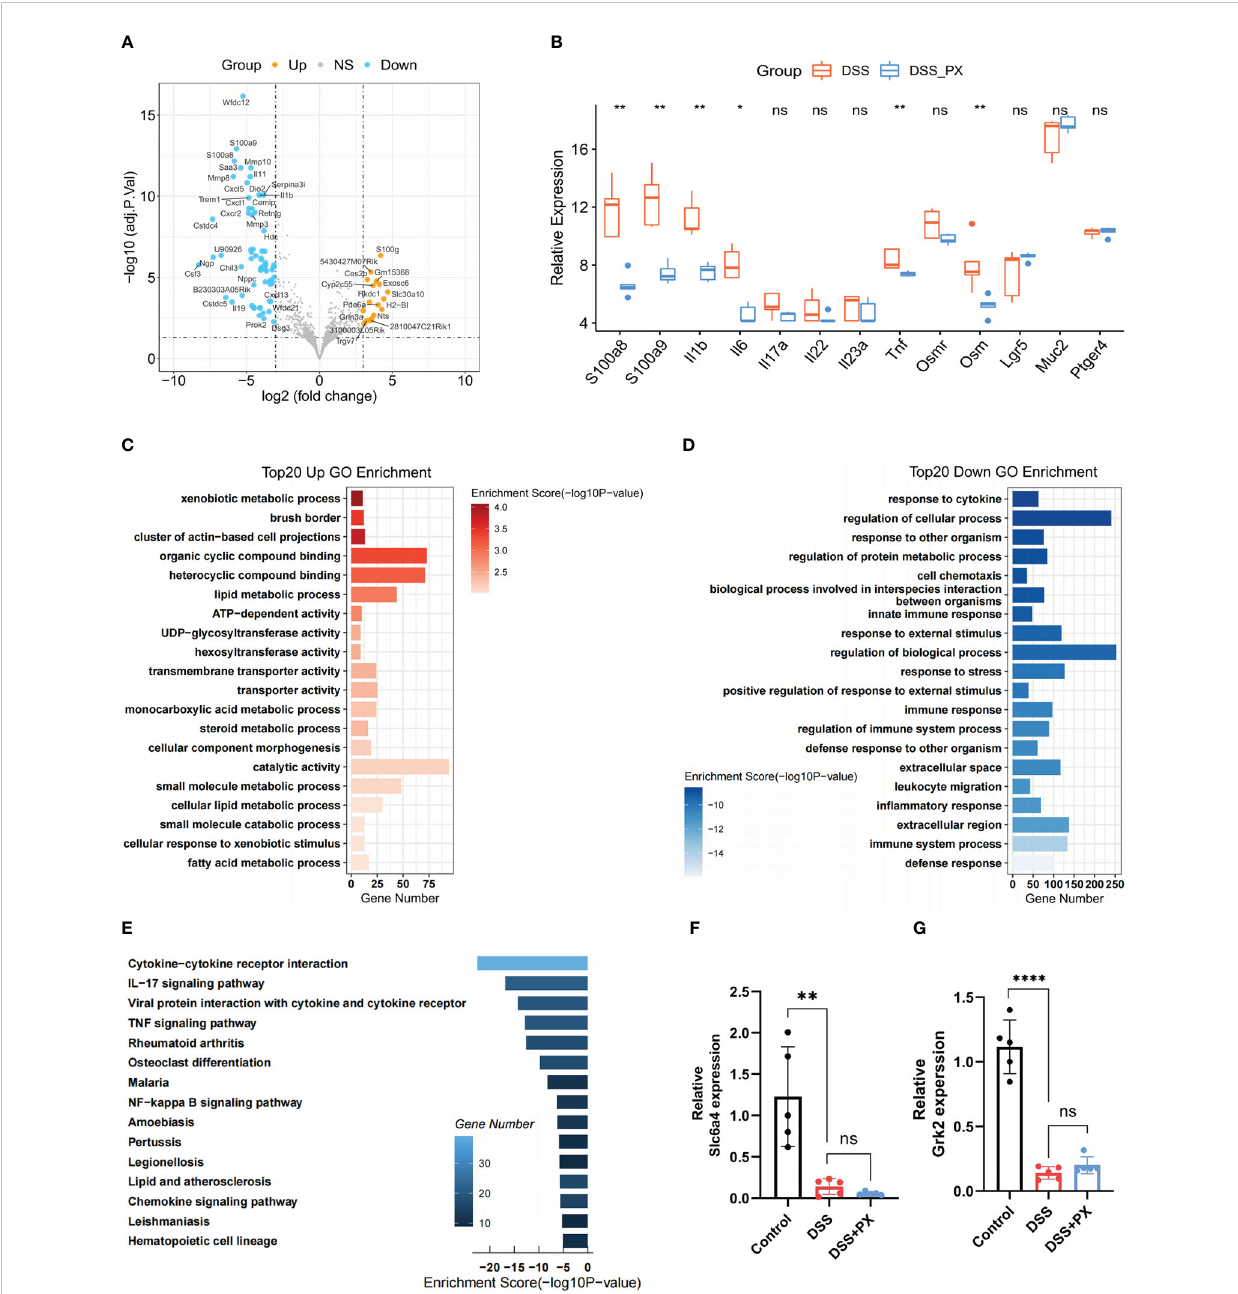
FIGURE 6 Paroxetine down-regulates multiple in fl ammatory pathways and alters host metabolism. (A) Volcano plot showing the differentially expressed genes between DSS+PX and DSS groups by RNA-seq. (B) Boxplot showing the mRNA expression levels of intestinal in fl ammatory markers (S100a8, S100a9, Tnf- a , Il-1b, Il-6, Il-17a, Il-22, Il23a, Ptger4), barrier function markers (Lgr5, Muc2), and anti-TNF-alpha-resistant biomarkers (Osm and Osmr) in DSS +PX versus DSS groups. The asterisks represented the statistical P-value. (C) GO enrichment analysis of top 20 upregulated genes in DSS+PX groups. (D) GO enrichment analysis of top 20 downregulated genes in DSS+PX groups. (E) KEGG analysis of downregulated DEGs between DSS+PX and DSS groups. (F) Quantitative PCR analysis of Slc6a4 expression in mice colon tissues of DSS+PX, DSS, and control groups. (G) Quantitative PCR analysis of Grk2 expression in mice colon tissues of DSS+PX, DSS, and control groups. Data are pooled from each independent experiment with n=5 mice per group; The asterisks represented the statistical P-value (ns P > 0.05; *P < 0.05; **P < 0.01; ****P <